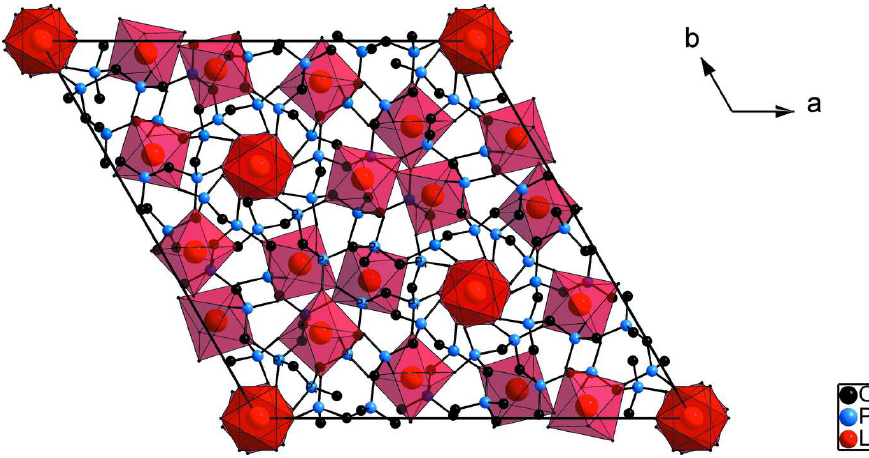
Figure 1 A projection of the helical (PO